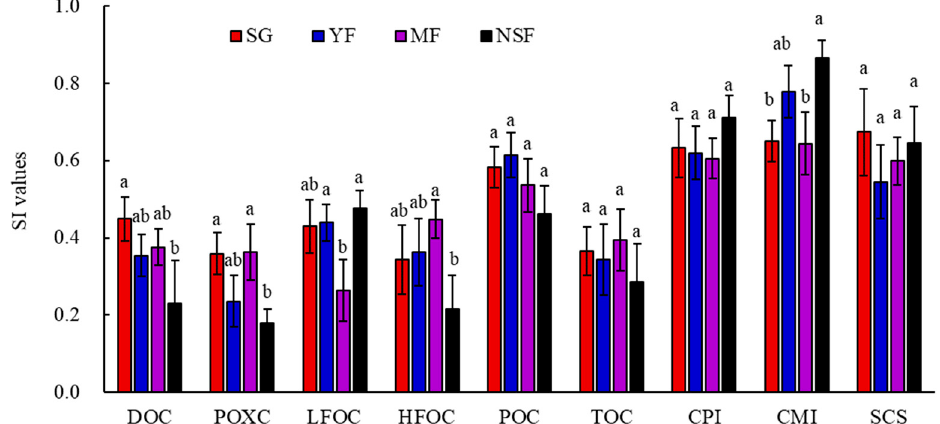
Figure 8. Sensitivity index (SI) values for the soil carbon indices for different vegetation restoration types relative to reference forest (natural forest). Values are the means ± standard error. The different letters for each carbon variable indicate significant differences between vegetation types at the 0.05 level.